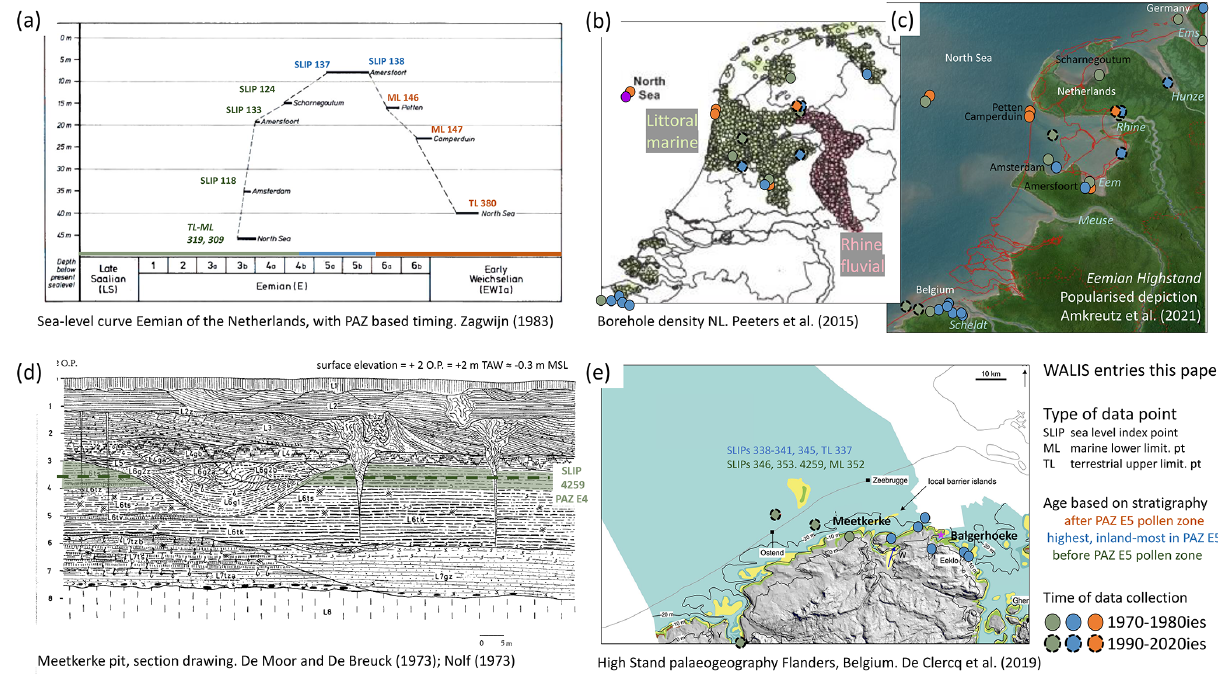
Figure A1. Selected figures illustrating research history and database contents for the Netherlands (a–c) and Belgium (d–e) , with annotations (database IDs, grouping early-, middle- and late-LIG points). (a) Sea-level curve of Zagwijn (1983). (b) Borehole density for the Netherlands (Peeters et al., 2015) overlain with legacy and more recent RSL data points. (c) Popularised depiction of Eemian highstand (Doggerland exhibition, Rijksmuseum voor Oudheden, Leiden; Amkreutz et al., 2021). (d) Exposure drawing of pit Meetkerke, Belgium (De Moor and De Breuck, 1973); elevation of SLIP highlighted. (e) Palaeogeographical map for Eemian highstand in Flanders for a series in De Clercq et al. (2018). Panels reproduced with permission ( a : Stichting NJG; b : Elsevier; c : RMO/Odé; d : present holder unknown, archived by https://www.vliz.be, last access: 1 November 2021; e :